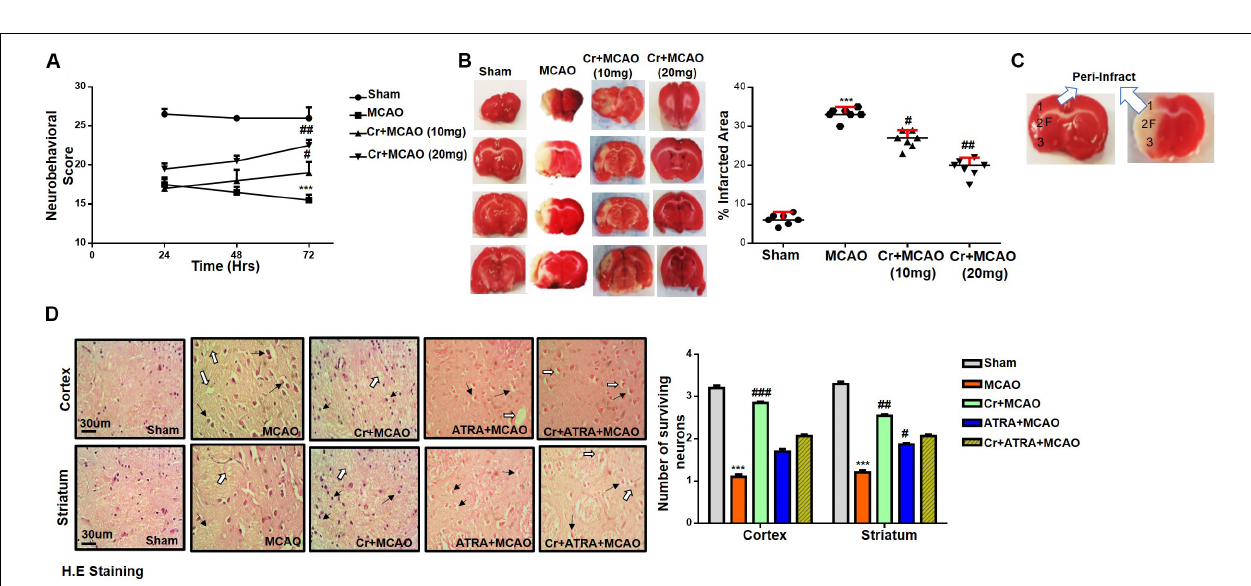
FIGURE 2 | Effect of post-treatment dosage regimen of carveol on brain infarction and neuronal cell loss. (A) 28 points composite scoring. CR + MCAO rats had significantly reduced neurological deficits ( # p < 0.05 vs ## p < 0.01) as compared to MCAO rats. Data are presented as mean ± SEM and analyzed by two-way ANOVA (group analysis) ( n = 7/group). (B) Brain coronal sections stained with TTC were used for analysis. Data are presented as mean ± SEM and analyzed by one-way ANOVA ( n = 7/group). *** p < 0.001, # p < 0.05, and ## p < 0.01 significantly different. The symbol * shows significant difference relative to sham while # shows significant difference relative to MCAO. (C) Coronal sections separated by frontal cortex (1), parietal cortex and insular cortex (2), and the piriform cortex (3). The analyzed region of interests indicated by 1 and F. (D) Representative images of hematoxylin and eosin staining in various groups ( n = 5/group), carveol used as 20 mg/kg and ATRA as 5 mg/kg. H.E slides were made by processing TTC thick coronal sections which were fixed in 4% paraformaldehyde. From the thick coronal TTC sections, paraffin blocks were made, and later 4 µ m thin coronal sections were prepared by a rotary microtome. Arrows indicate shrunken and condensed nuclei and open arrows indicate swelled and vacuolated forms. Scale bar = 50 µ m. * Significant difference relative to control; # significant difference relative to MCAO group. All data are presented as means ± SEM. Data were analyzed using two-way ANOVA followed by post hoc Bonferroni multiple comparison test using GraphPad Prism 6 software. ***Indicates p < 0.001 shows significant difference relative to sham control while, ## indicates p < 0.01 and # indicates p < 0.05 showing significant difference relative to MCAO group.